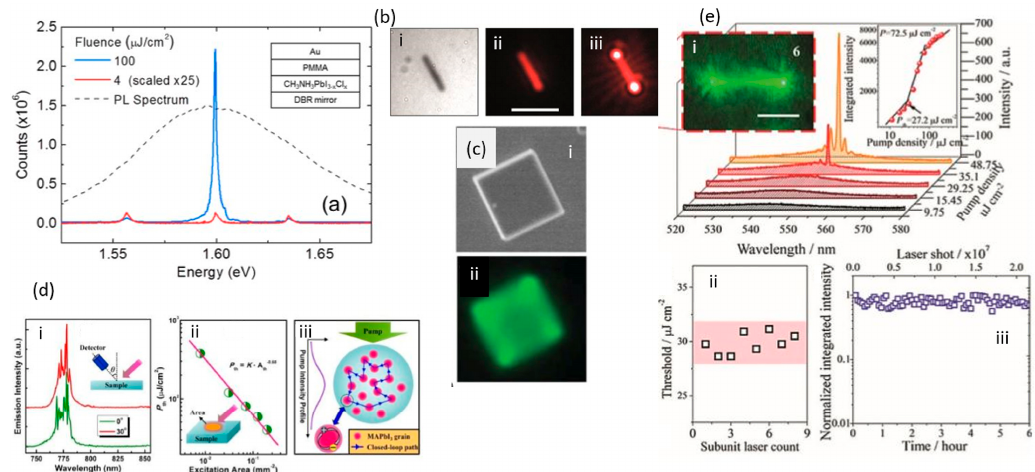
Figure 3. ( a ) Lasing from a Fabry-Perot type Perovskite Laser. Reproduced with the Permission from